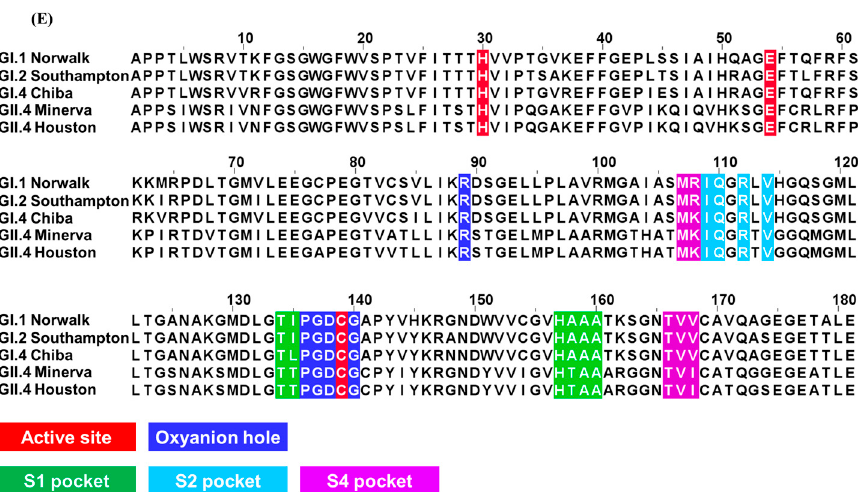
Figure 1. Three-dimensional structure of HuNoV protease and its active site. ( A ) Ribbon represen- tation of Norwalk protease structure (PDB ID: 2FYQ). Domain I (cyan) is connected to Domain II (lime) via a large loop (orange). The catalytic residues are shown as red stick models. The β -strands are shown as yellow characters with red outline. ( B ) The active site of HuNoV protease contains three residues colored red. ( C ) Structures of all the published protease are overall conserved with several regions exhibiting conformation flexibility, indicated by the red arrows. The five regions are: (1) the flexible surface loop from aa 33 to 36, (2) the hairpin loop from aa 107 to 113, (3) the short loop from aa 147 to 150, (4) the β -hairpin loop from aa 162 to 164, and (5) the loop from aa 122 to 134 ( D ) Conservation of amino acid positions in HuNoV protease structures. The figure was generated with the ConSurf server [69]. ( E ) The amino acid residues are colored in red for the active site, blue for the oxyanion hole, green for the S1 pocket, cyan for the S2 pocket, and magenta for the S4 pocket. The GenBank accession ID for each sequence is Norwalk, NP_786949.1; Southampton, AAA92983.1; Chiba, AB042808.1; Minerva, EF684915; Houston,